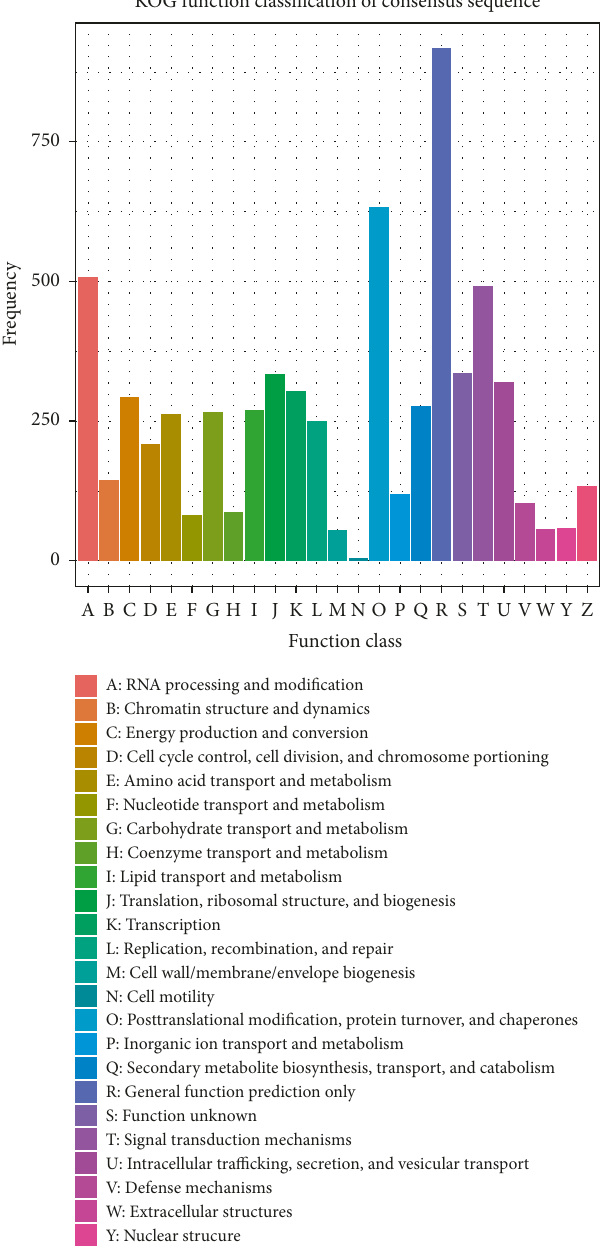
Figure 1: Classification of S. latifolia proteins by the Eukaryotic Clusters of Orthologs (KOG)